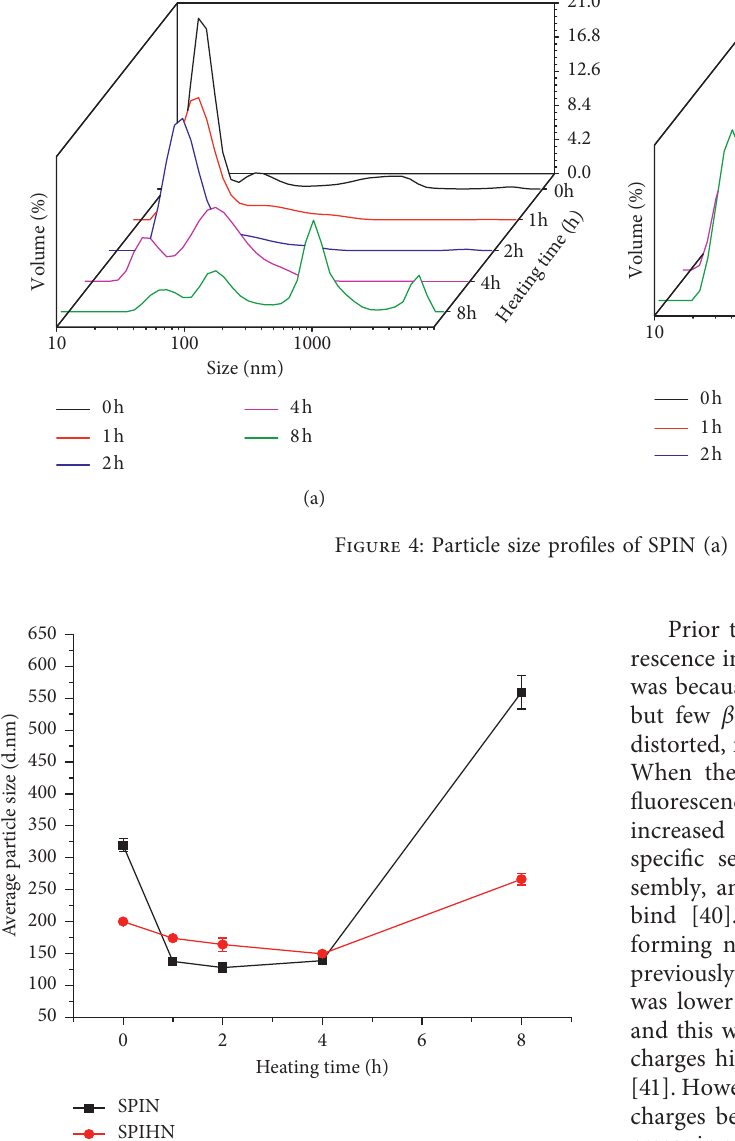
Figure 5: The average particle size profiles of SPIN and